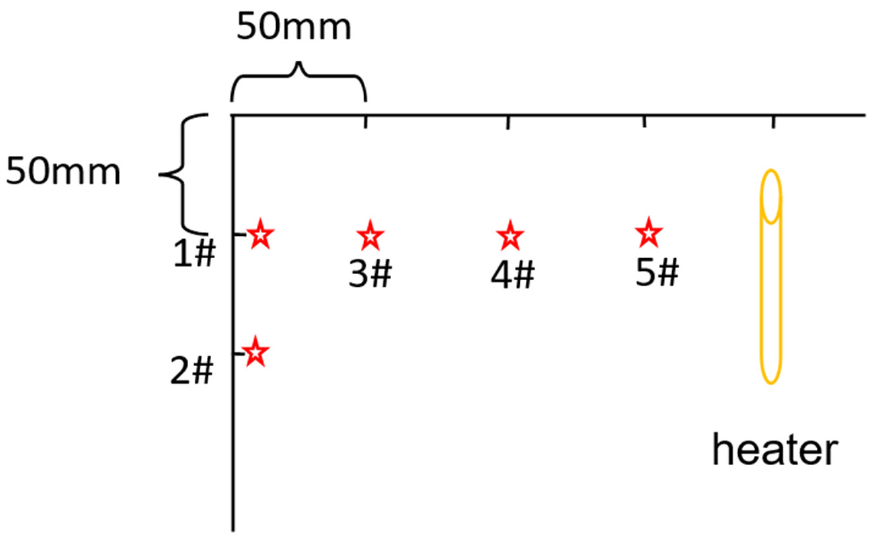
Figure 11. Arrangement of heating source and temperature sensors in the incubator. 1#–5# in the figure represent temperature sensors 1–5.